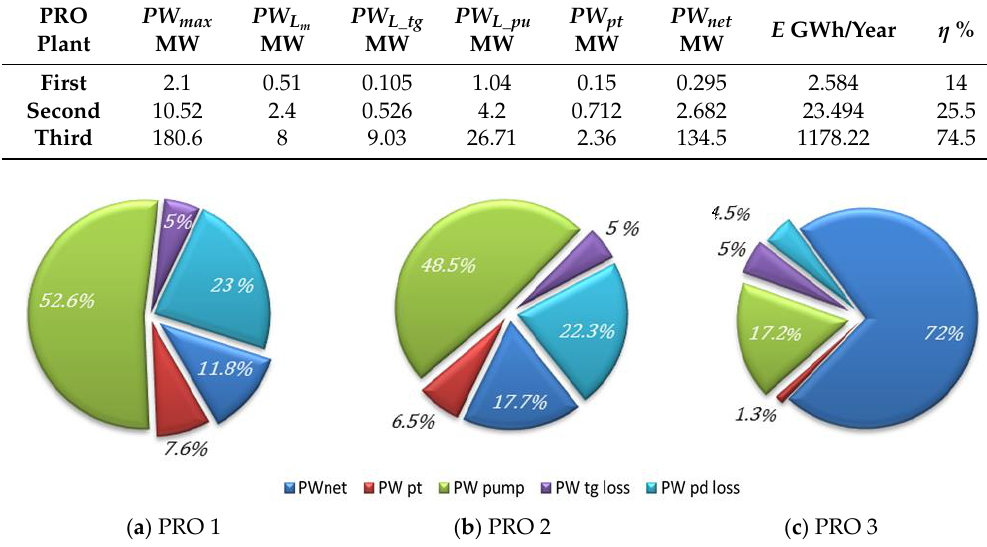
Figure 7. Percentage of the different power losses and net power production from the three PRO power plants.